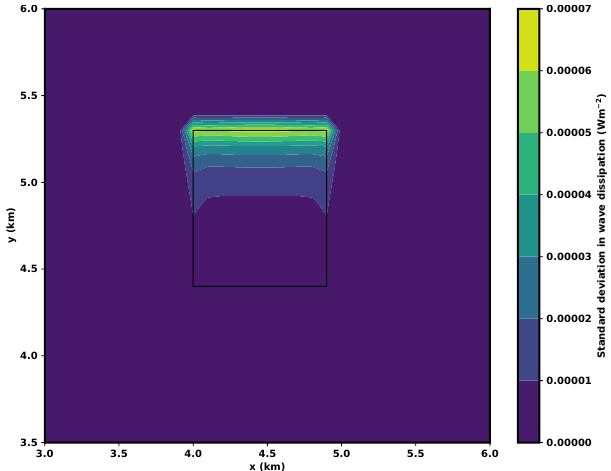
Figure 4. Standard deviation from wave dissipation (Wm − 2 ) in the presence of vegetation (plan view). The area of the vegetation patch is highlighted in the middle of the domain.